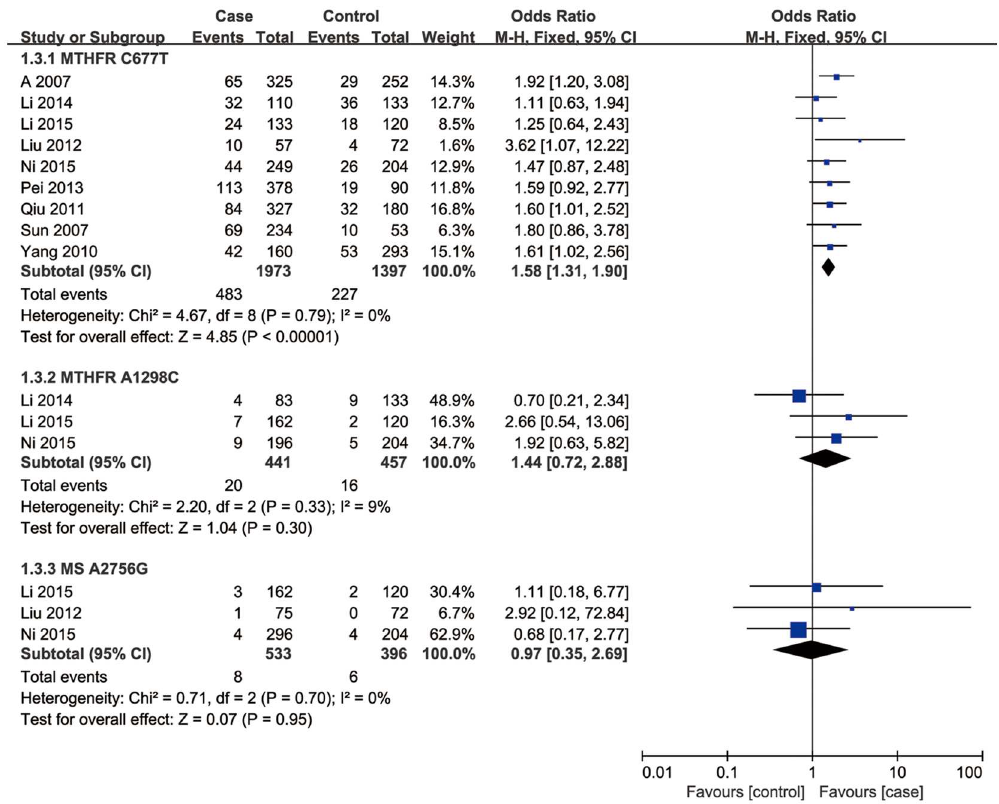
Fig 5. Forest plot of the studies assessing the association between MTHFR C677T, MTHFR A1298Cand MS A2756Gpolymorphisms and male infertility. (recessivemodel: (a) TT vs. CC+CT, (b) CC vs. AA+AC, (c) GG vs.